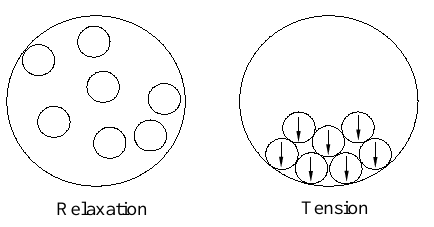
Figure 1. The friction in pre-stressed tendons.